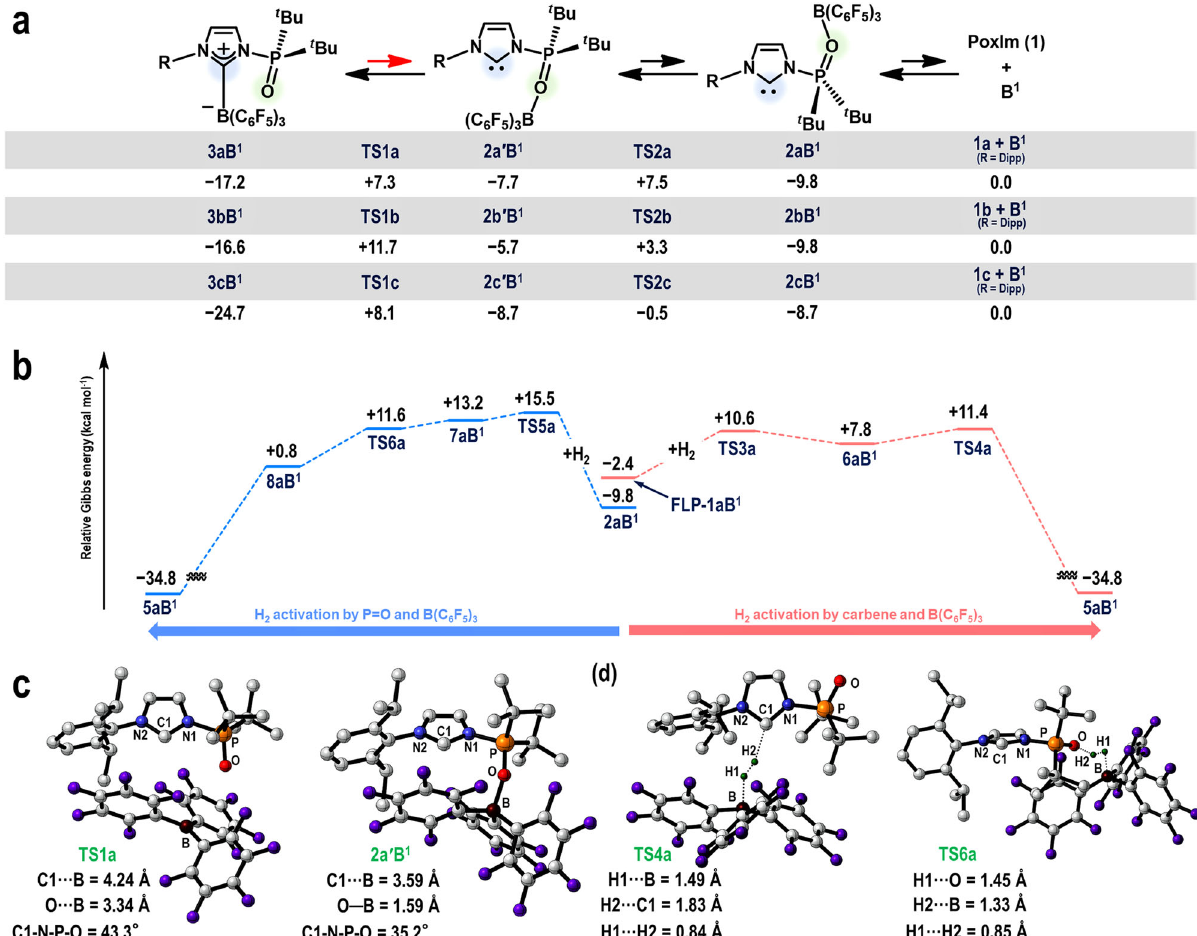
Fig. 5 Theoretical studies. The relative Gibbs energies [kcal mol ‒ 1 ] are shown with respect to each [ 1 + B 1 ], calculated at the ω B97X-D/6-311G(d,p), PCM (DCE)// ω B97X-D/6-31G(d,p) (for H 2 ) and 6-31G(d) (for all other atoms) level of theory (298.15 K, 1 atm). a Proposed mechanism for the regeneration of [ 1 + B 1 ] from the carbene ‒ borane complexes 3aB 1 ‒ 3cB 1 . b Proposed mechanism for the heterolytic cleavage of H 2 , enabled by the phosphinoyl oxygen